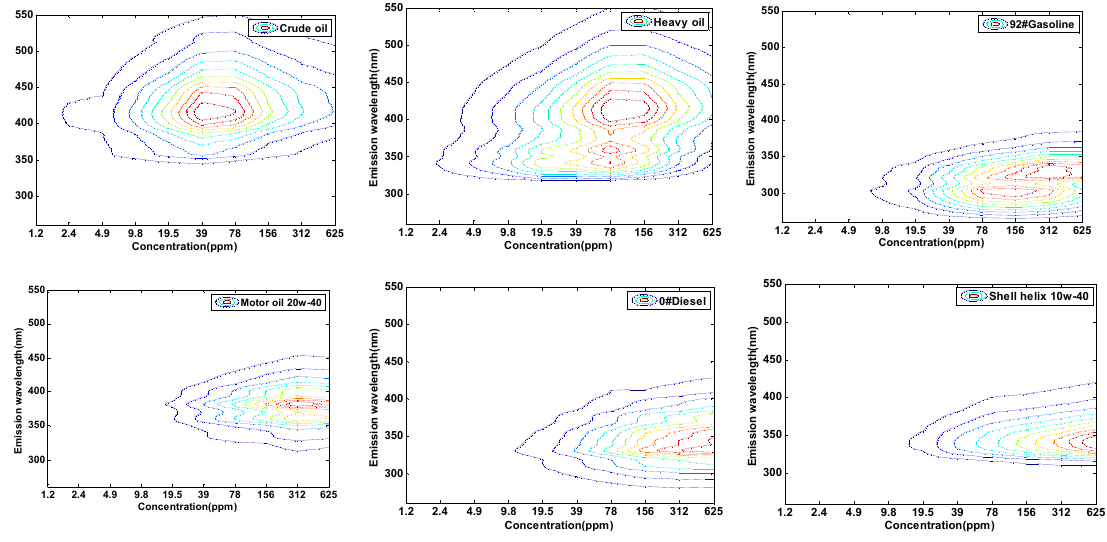
Figure 1. Concentration-emission matrix (CEM) spectra of 6 kinds of oil samples.